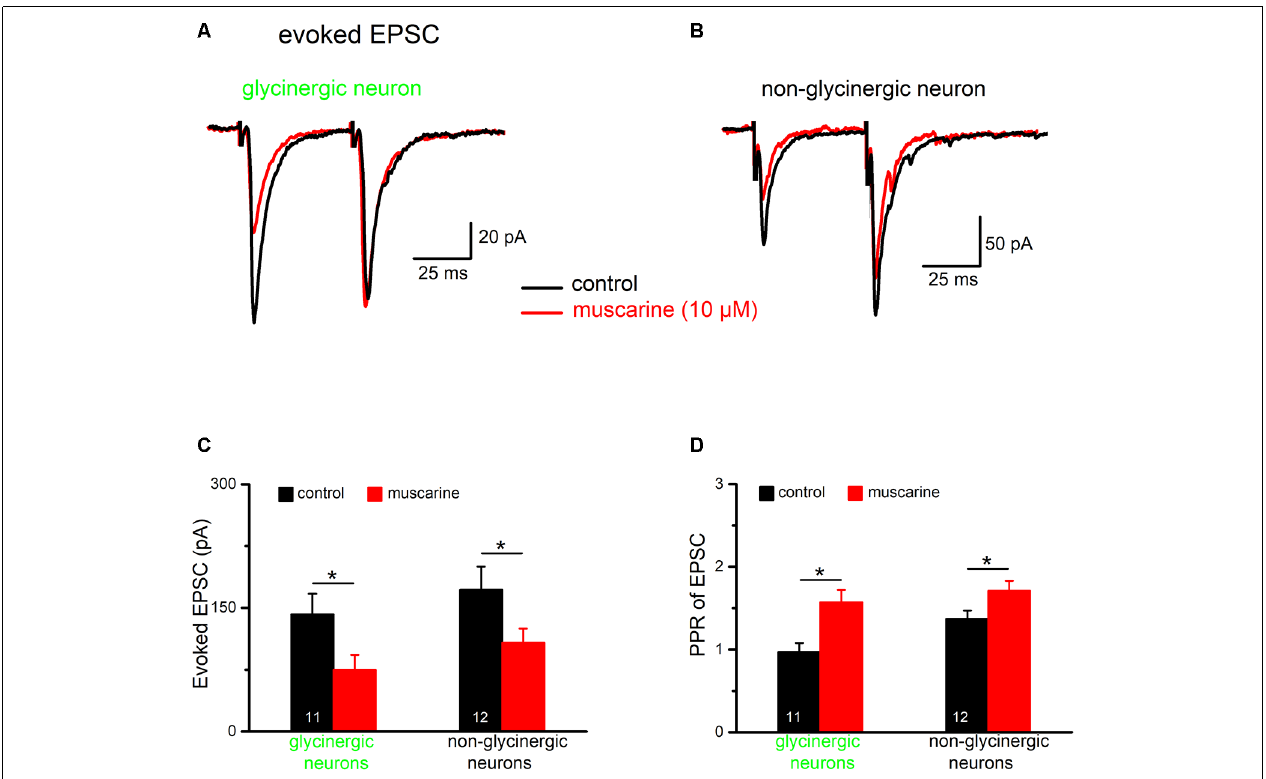
FIGURE 9 | Muscarine suppresses EPSCs in preBötC neurons. Representative voltage-clamp recordings of pairs of evoked EPSCs (stimulus interval was 50 ms) made in the presence of picrotoxin (100 µ M) and strychnine (10 µ M) in the bath. (A,B) Superimposed traces recorded before and during bath application of muscarine (10 µ M) in two types of preBötC neurons. Note that in control perfusate, the glycinergic neuron showed PPD while the non-glycinergic neuron showed PPF. Muscarine reduced the amplitude of the 1st EPSC in both groups of neurons as summarized in the histograms shown in (C) . The graph in (D) summarizes muscarinic effects on PPR of EPSC in the two groups of neurons. This figure shows that muscarine turned the prevailing PPD (PPR < 1) in glycinergic neurons into PPF (PPR > 1; ∗ p <